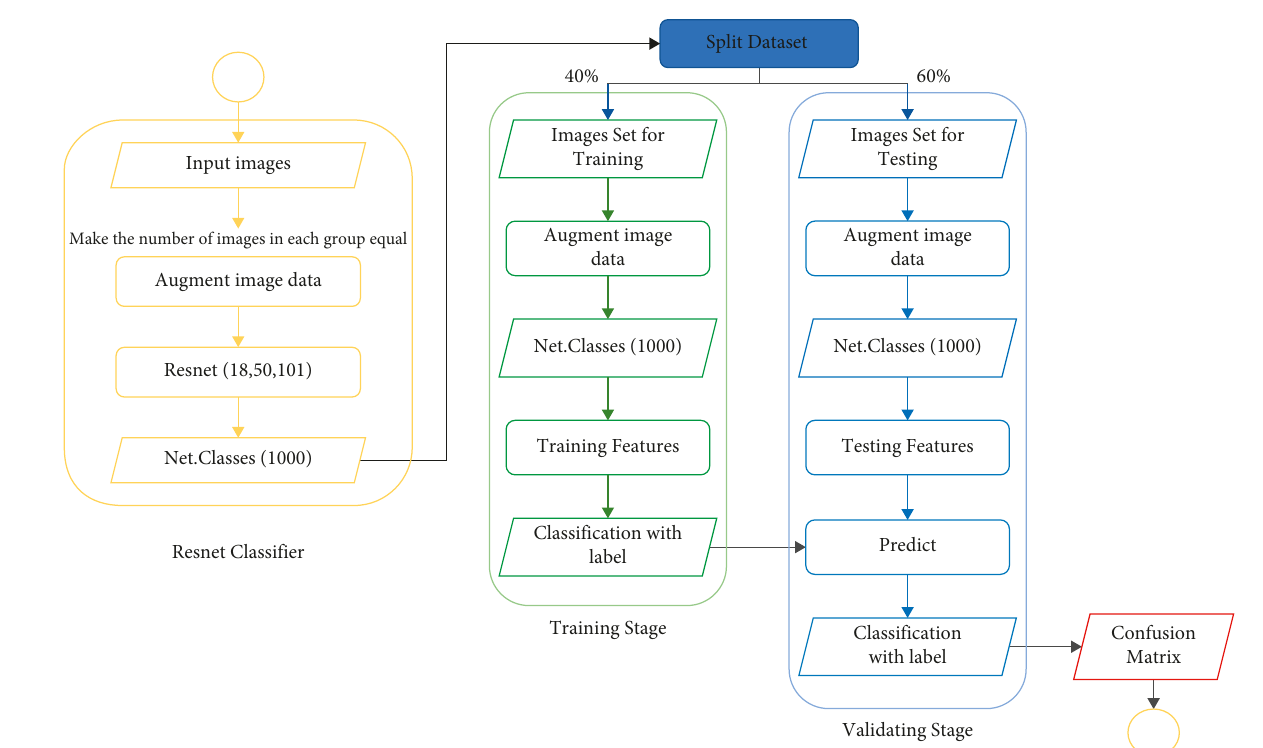
Figure 5: ResNet 101 architecture.